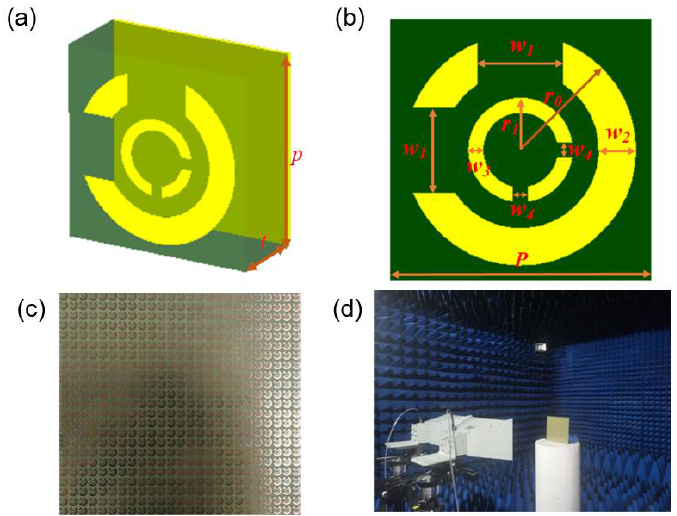
Figure 1. ( a ) Three-dimensional view of the polarizer; ( b ) front view of the polarizer; ( c ) photo of the experimental samples (25 × 25 cells with dimensions of 175 mm × 175 mm); ( d ) measurement environment